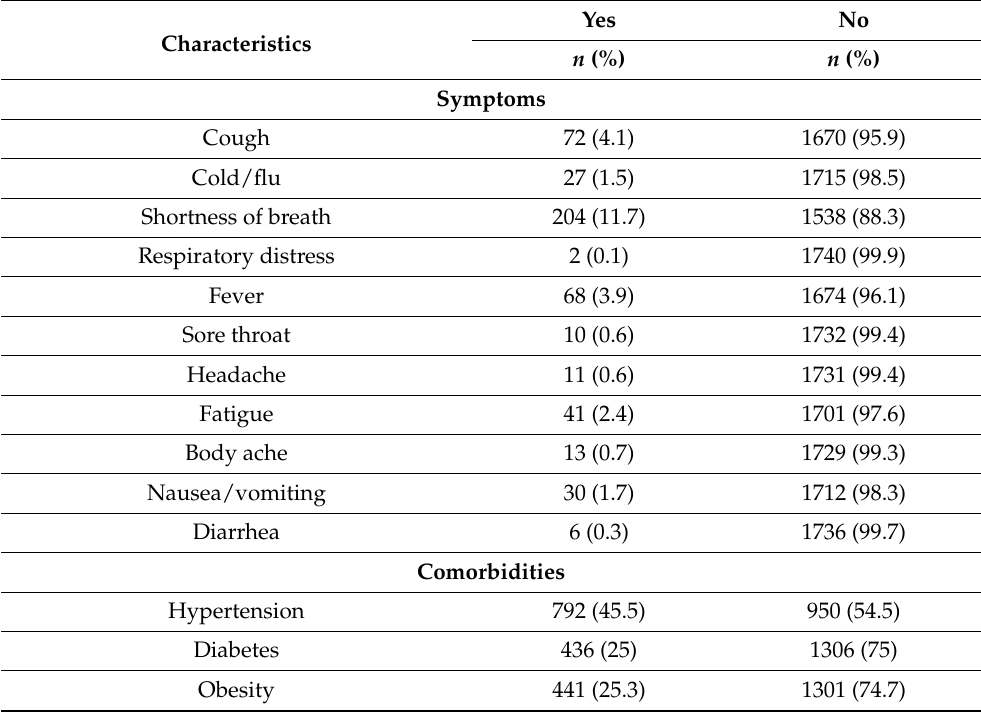
Table 1. Clinical characteristics, treatments, and outcomes of patients attending hospitals affiliated with West Virginia University ( n =